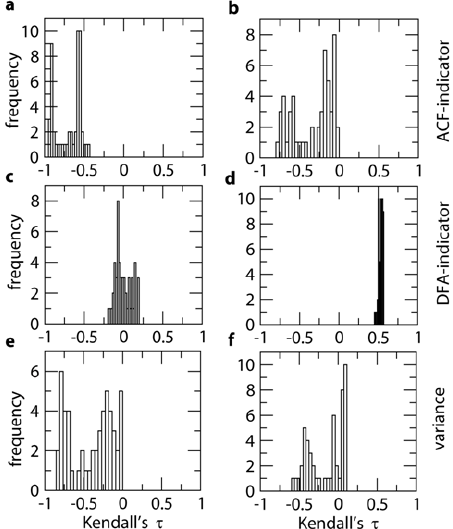
Fig. A4. Destabilisation indicators calculated up to 2007. From (a) , (c) , (e) sea-ice area anomaly, (b) , (d) , (f) sea-ice extent anomaly (both after detrending). Sensitivity analysis when varying sliding window length for Kendall trend statistic of (a) and (b) ACF- indicator, (c) and (d) DFA-indicator, (e) and (f)